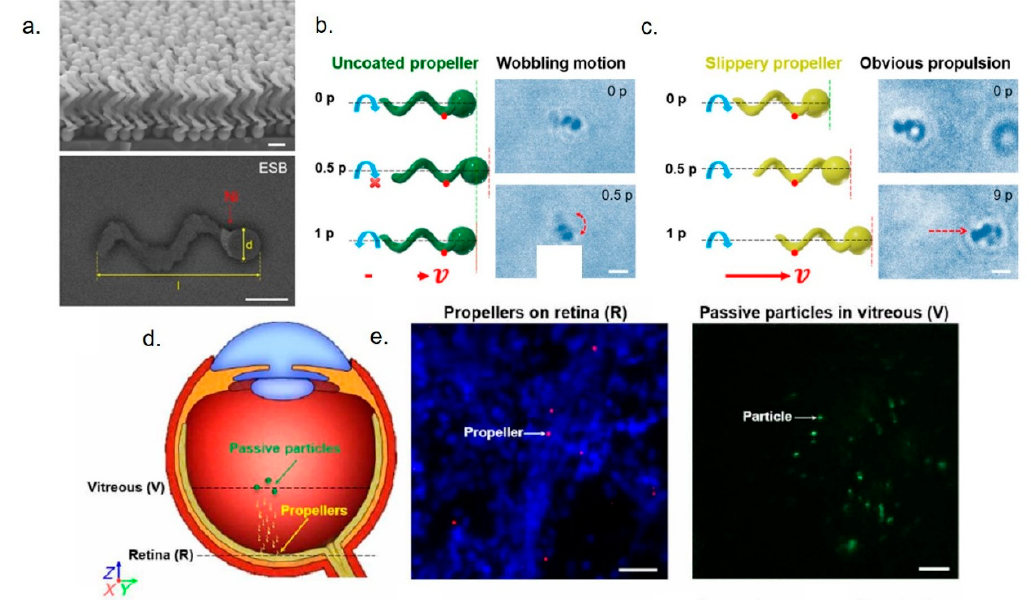
Figure 7. ( a ) SEM and ESB-SEM images of the micropropellers. ( b , c ) incomplete rotation of an uncoated micropropeller for one period (p) in the vitreous was showed in schematic and time-lapse microscopy, whereas the coated propeller exhibited propulsion under magnetic stimuli in vitreous for 1.5 s (nine periods). Red arrows showed the propulsion direction of propeller. The original position of nanotools and after the rotating magnetic field application were showed with green and red dashed lines. Scale bars, 1 µ m. ( d ) Schematic illustration of micropropeller movement in the vitreous. ( e ) Left: fluorescent acquisitions showed the micropropellers labelled red on retina. Right: passive fluorescent particles were accumulated near center of vitreous. Nuclei of cells were stained with DAPI. Scale bar, 20 µ m. Adapted from reference [155] under the terms of the Creative Commons Attribution-Non Commercial license.